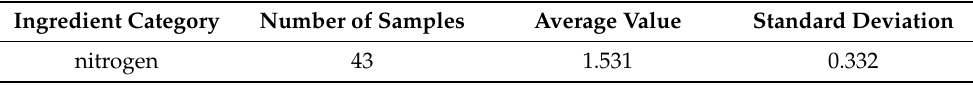
Table 6. Soil sample prediction set component content statistics table.